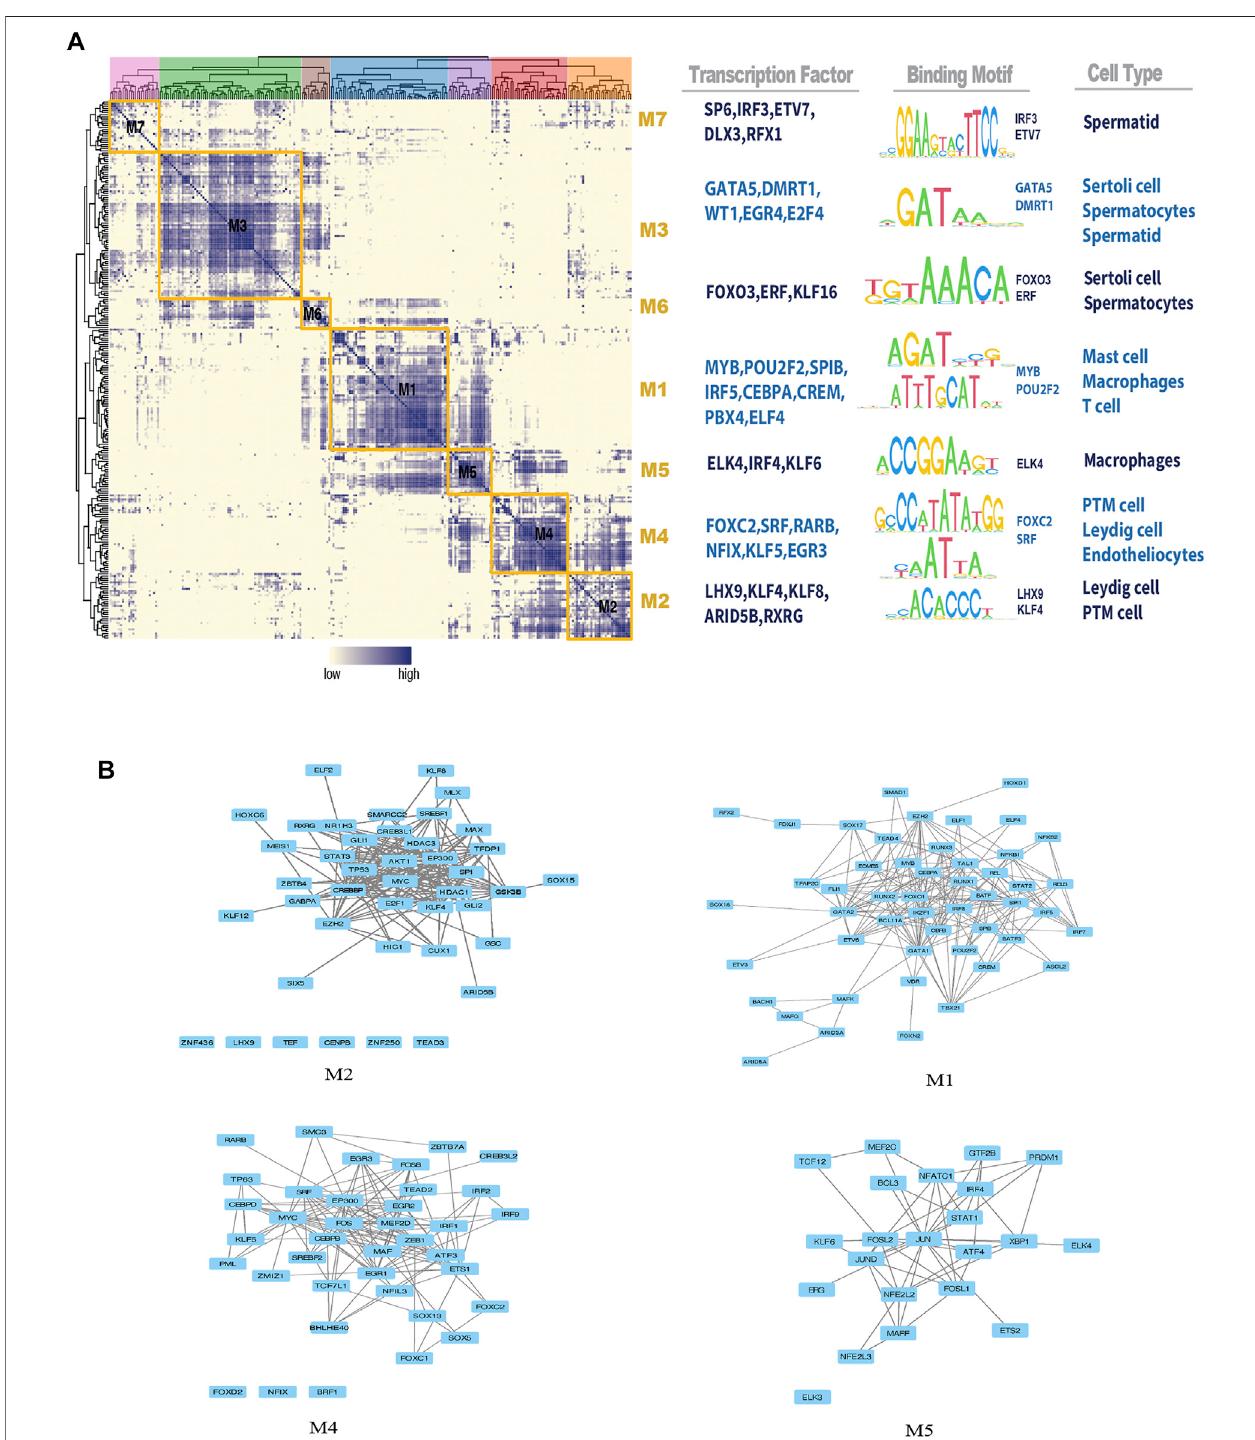
FIGURE 6 | Identi fi cation of combinatorial regulon modules. (A) Determination of the regulon modules based on the regulation connection speci fi city index (CSI) matrix, along with associated cell types, corresponding binding motifs, and representativetranscription factors (TFs). (B) Protein-protein interaction networks (PPINs) of regulatory factors in each